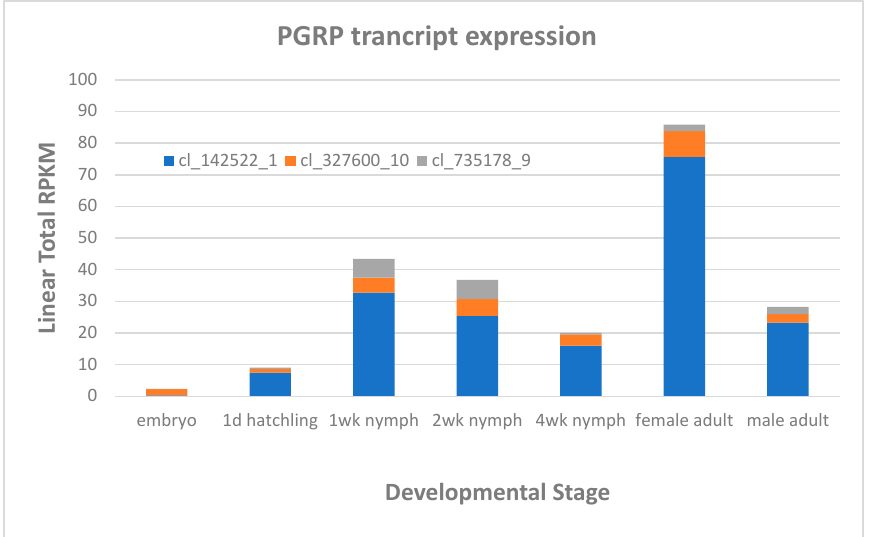
Figure 2. Expression profiles of three potential PGRP transcripts from A. domesticus developmental stages or male and female adults. The figure legend has the identification of transcripts from a previous transcriptome assembly [22].